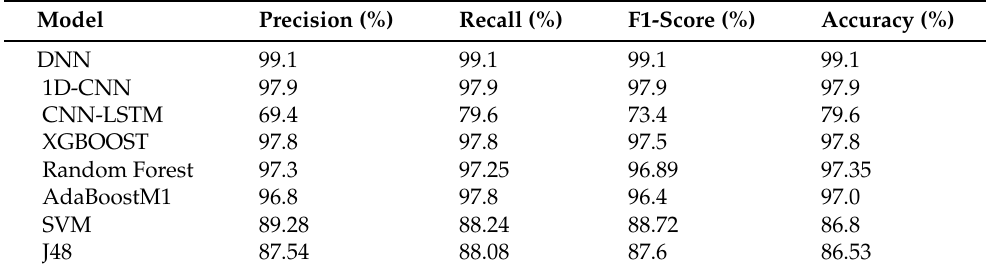
Table 2. Results of models on Virusshare dataset.